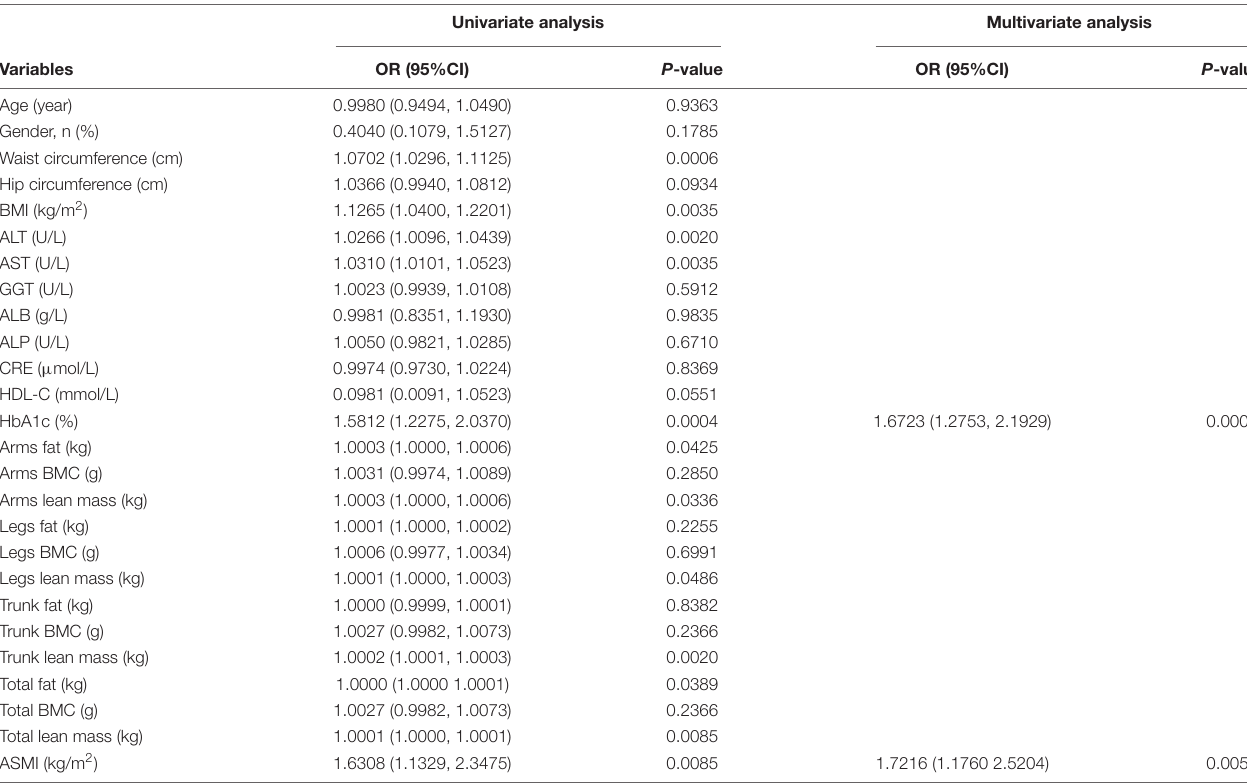
TABLE 3 | Univariate and multivariate analysis of variables associated with liver steatosis.